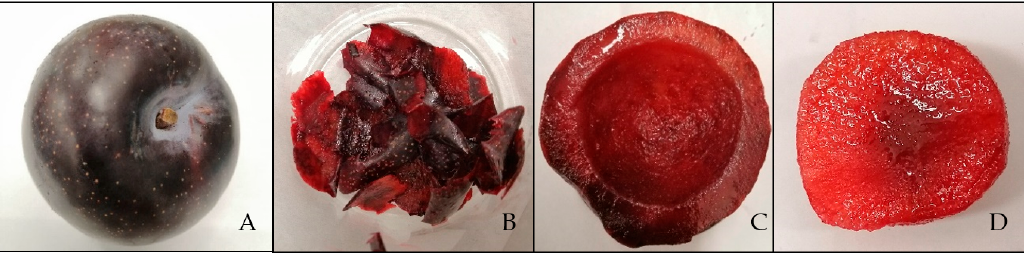
Figure 1. ( A ) Mature Queen Garnet plum (QGP); ( B ) Peel; ( C ) Outer flesh (OF); ( D ) Inner flesh (IF).